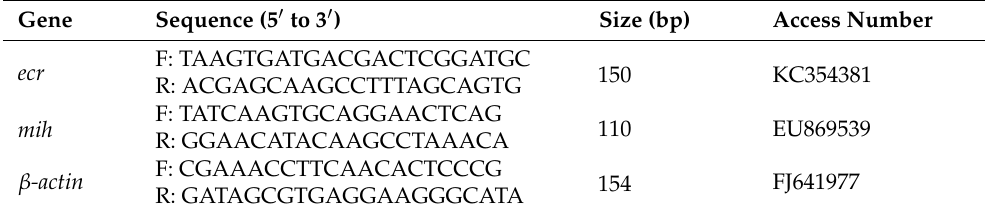
Table 1. Specific primers were used for real-time PCR in this